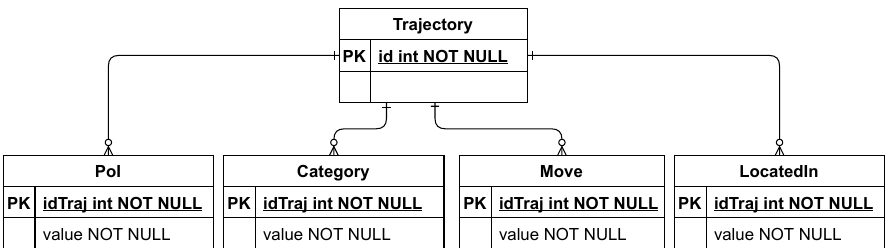
Figure 5. ER diagram of the textual trajectories